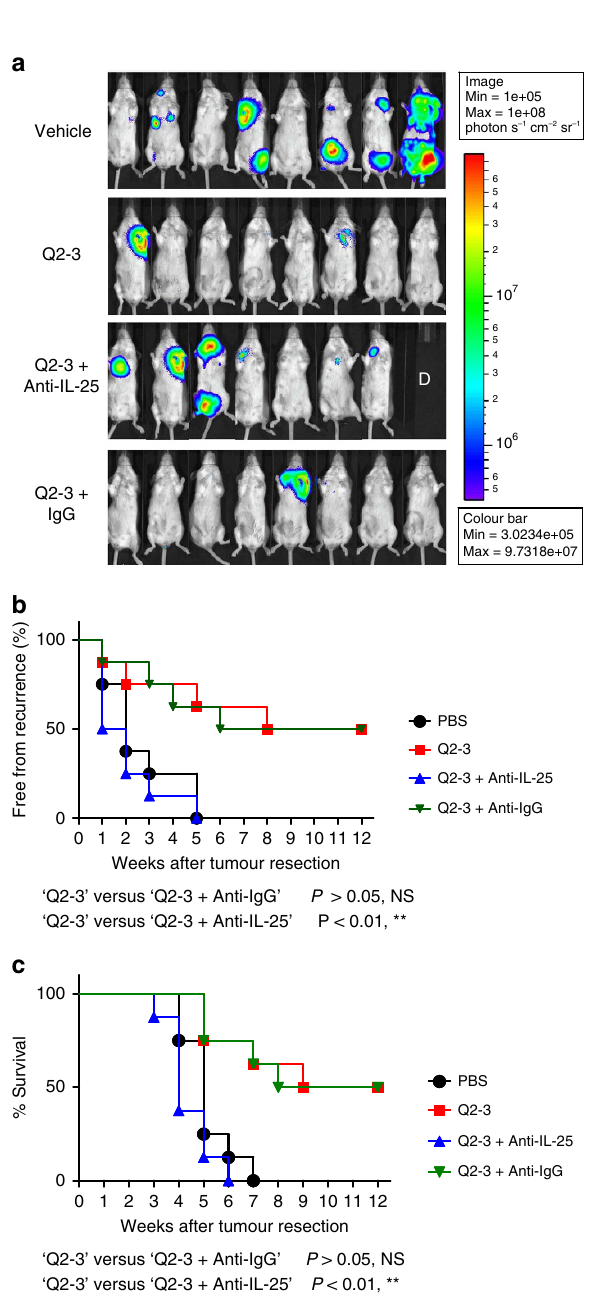
Figure 5 | In vivo neutralization of IL-25 activity can effectively invalidate the anti-metastatic activity of Q2-3. ( a ) Representative bioluminescent